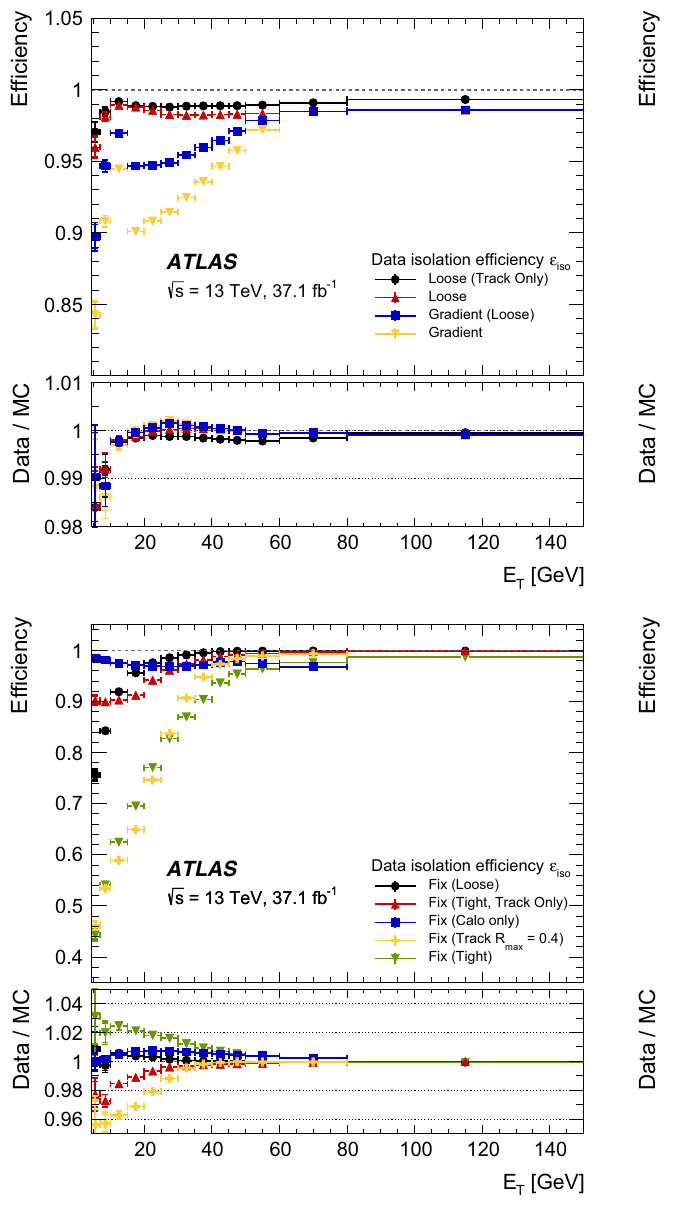
Fig. 12 Isolationefficienciesfordata(intheupperpanels)andtheratio to simulation (lower panels) for the operating points given in Table 4 as a function of candidate-electron E T (left) and η (right) in Z → ee events. Top plots: efficiencies for optimised operating points target- ing specific efficiencies. Bottom plots: efficiencies for operating points where fixed requirements are applied to the isolation variables.